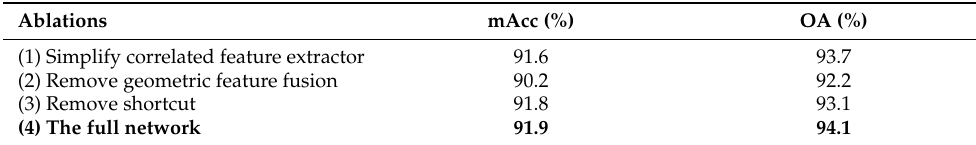
Table 4. The classification performance of ablated network on ModelNet40. The bolded text indicates the best results.